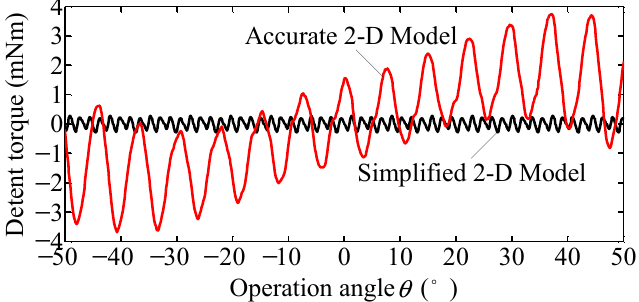
Figure 18. Calculated detent torque of sub-motor1 by using 2-D FEA.